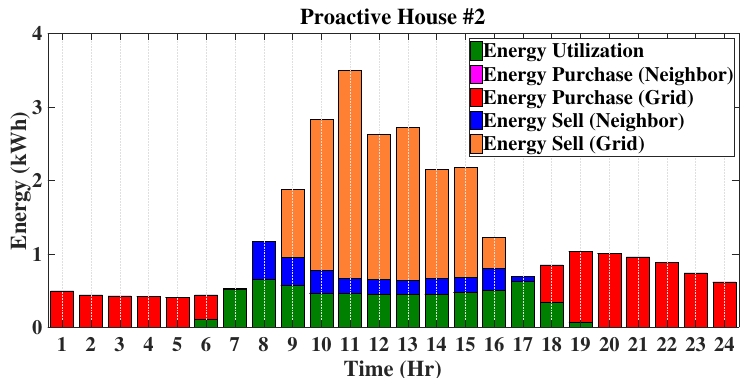
Figure 14. Energy profiles of Proactive House #2 on a typical summer day.